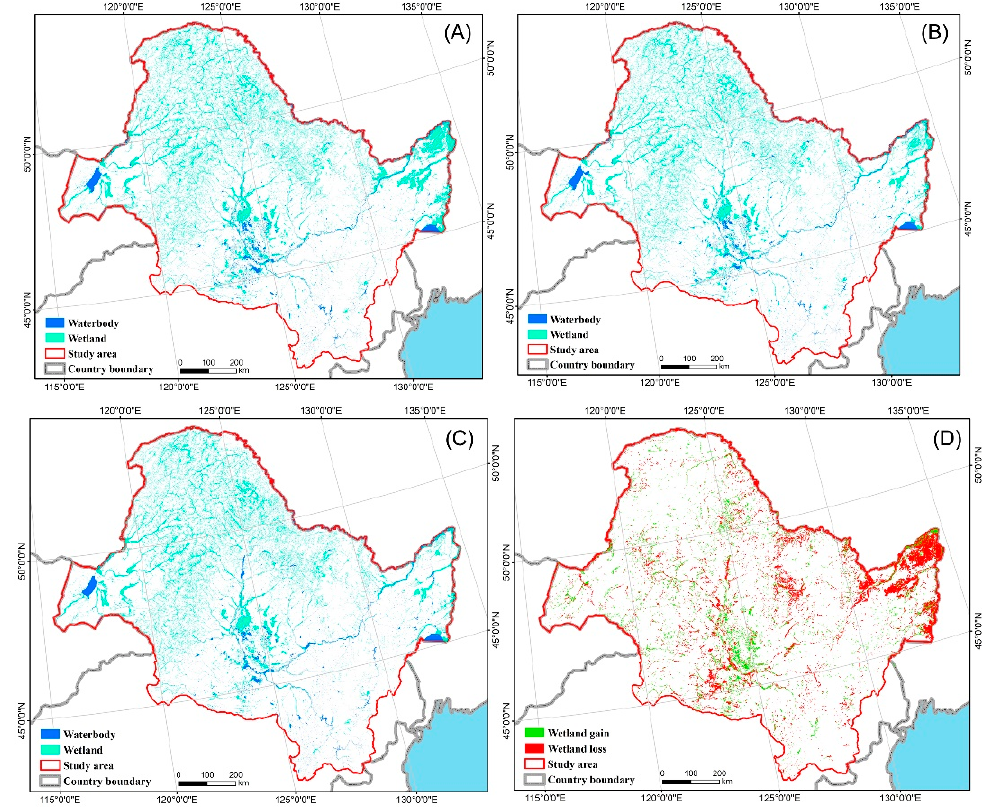
Figure 5. Geographical distributions of wetlands and waterbody on the CARB. ( A ) Wetland and water body in 1990; ( B ) Wetland and water body in 2000; ( C ). Wetland and water body in 2010; ( D ) Loss and gain of wetland during 1990–2010.